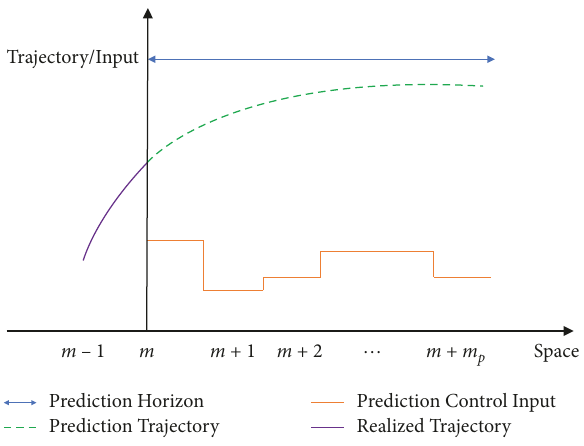
Figure 3: Illustration of model predictive